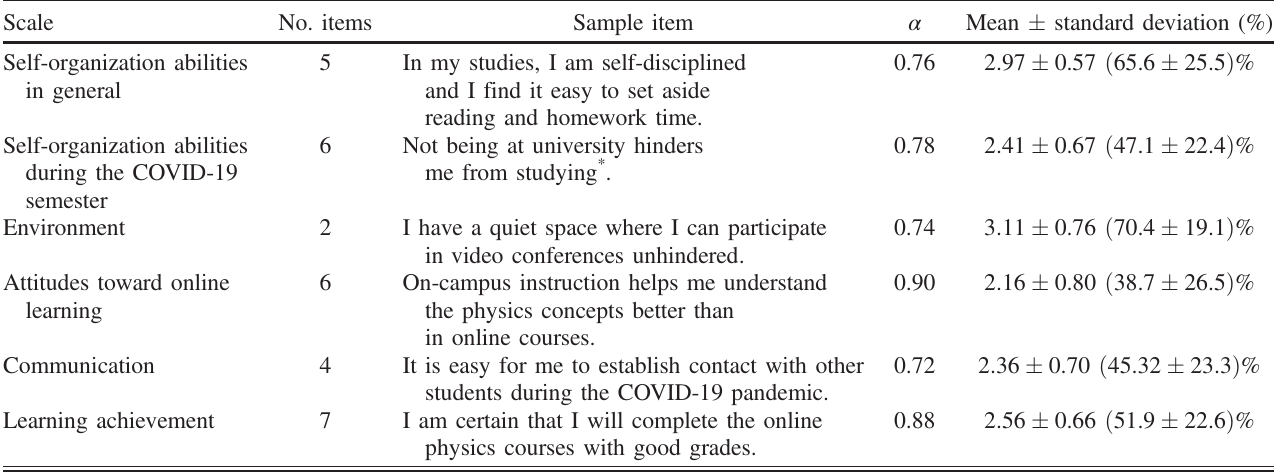
TABLE I. Description and psychometric characteristics of the scales that were used for all students. Scale